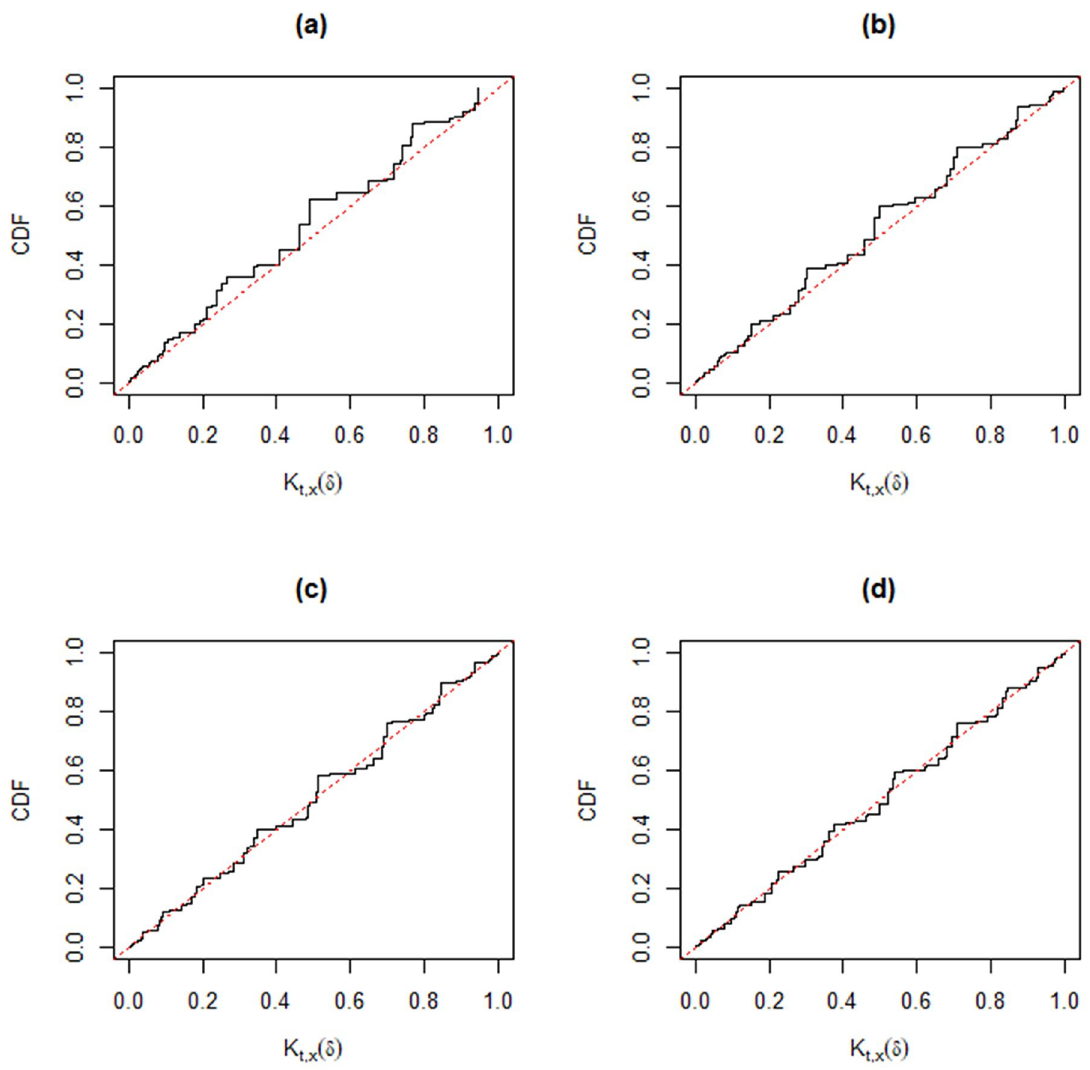
Fig 5. Distribution functions of K ( δ ) (black) compared with that of Unif(0, 1) (gray) based on Monte Carlo samples from the t , x trinomial distribution versus p 12 for fixed n = 20 and p 11 = 0.3. Panel (a): p 12 = 0.1. Panel (b): p 12 = 0.2. Panel (c): p 12 = 0.3. Panel (d): p 12 =